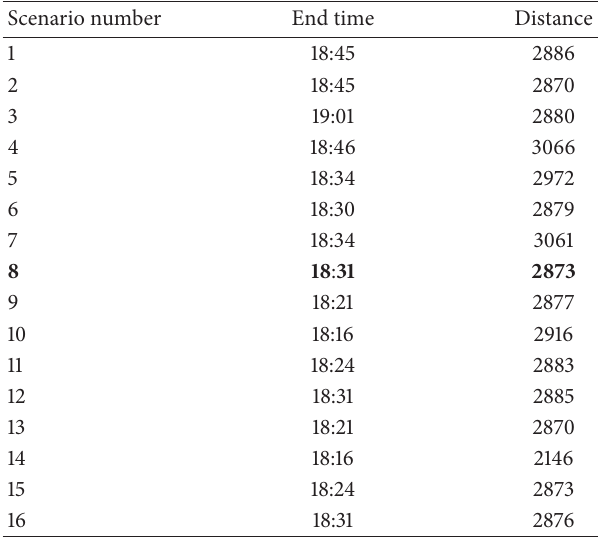
Table 4: Optimal solutions under various balance